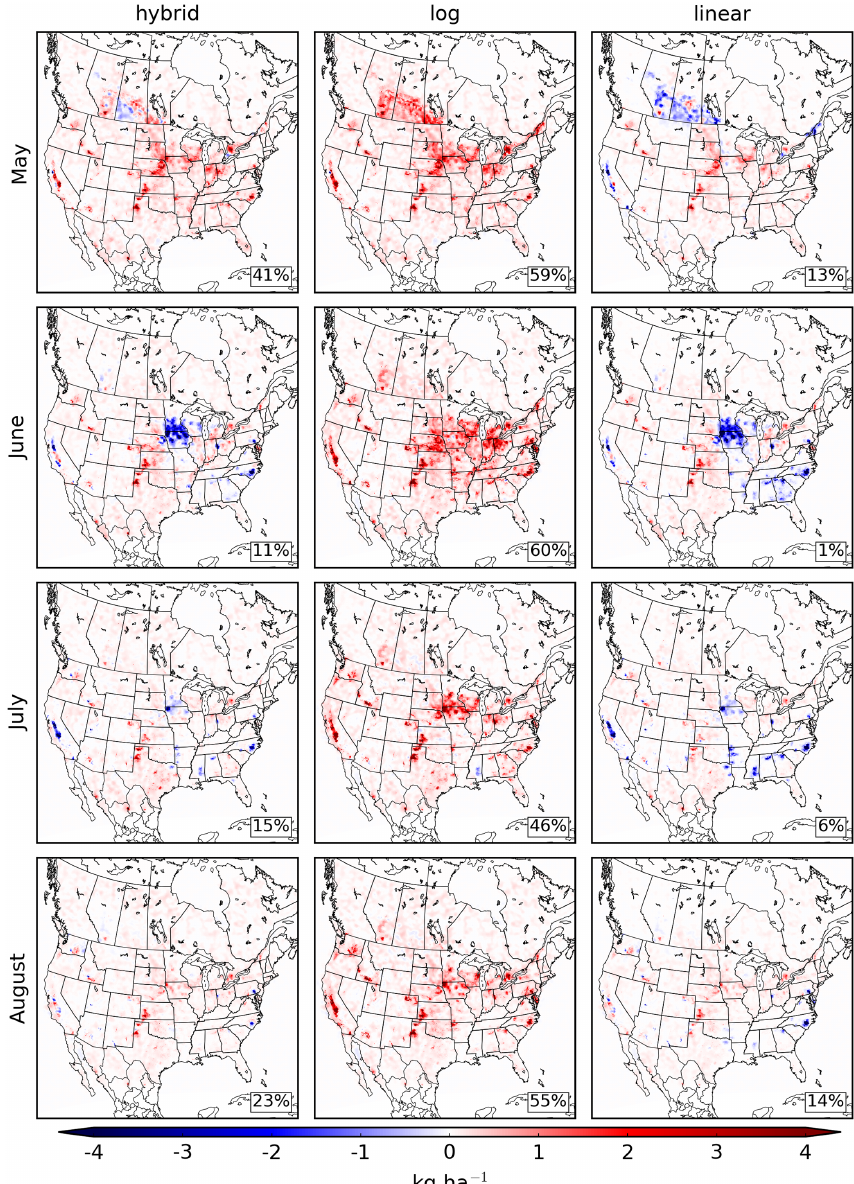
Figure 8. Monthly mean ammonia emissions increments for May to August 2016 for inversions using different observation operators. Inversions displayed in the left, middle, and right columns use the hybrid, log, and linear observation operators, respectively. The left column, which is identical to the right column of Fig. 3, is shown for comparison. Percentages in the lower right corners show the change over the whole